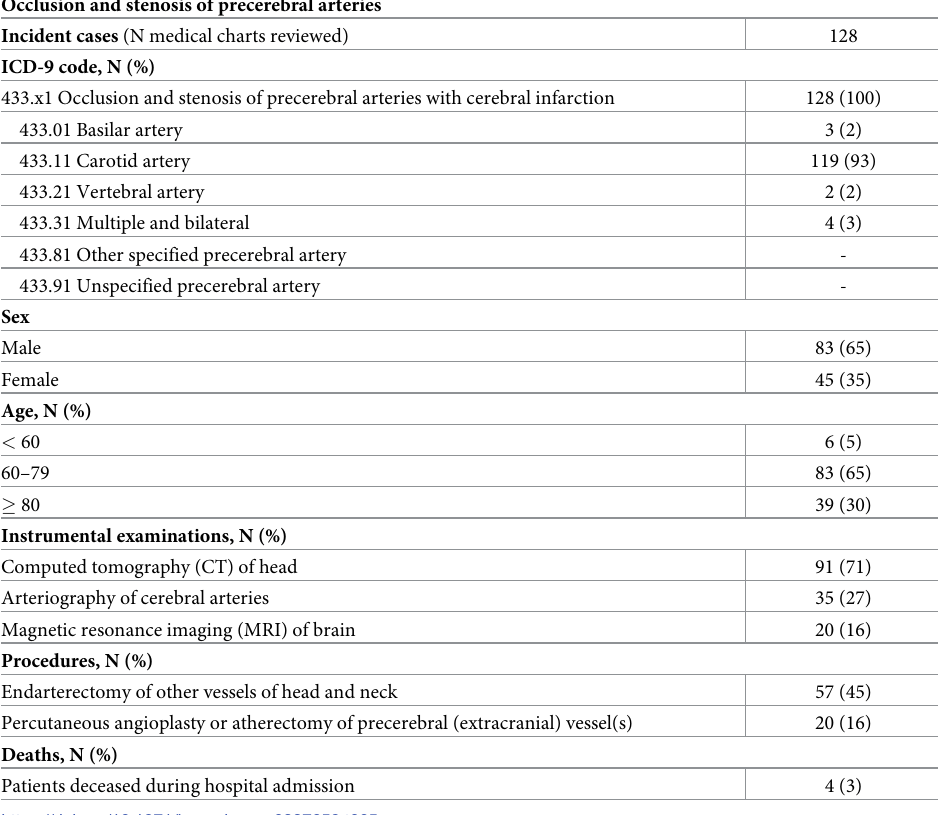
Table 5. Characteristics of patients with occlusion and stenosis of precerebral arteries who were identified in the Regional Administrative Database of Umbria. Occlusion and stenosis of precerebral arteries Incident cases (N medical charts